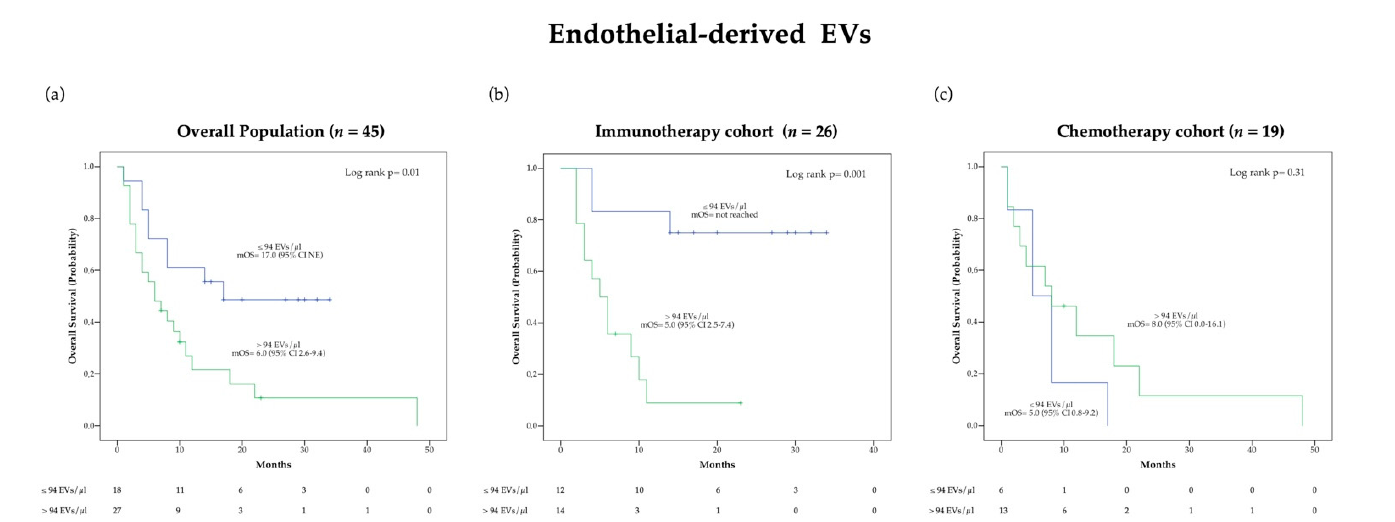
Figure 2. Kaplan-Meier (KM) curves examining the relationship between overall survival and blood circulating endothelial-derived EV concentration before treatment in the overall population ( a ), the immunotherapy cohort ( b ) and the chemotherapy cohort ( c